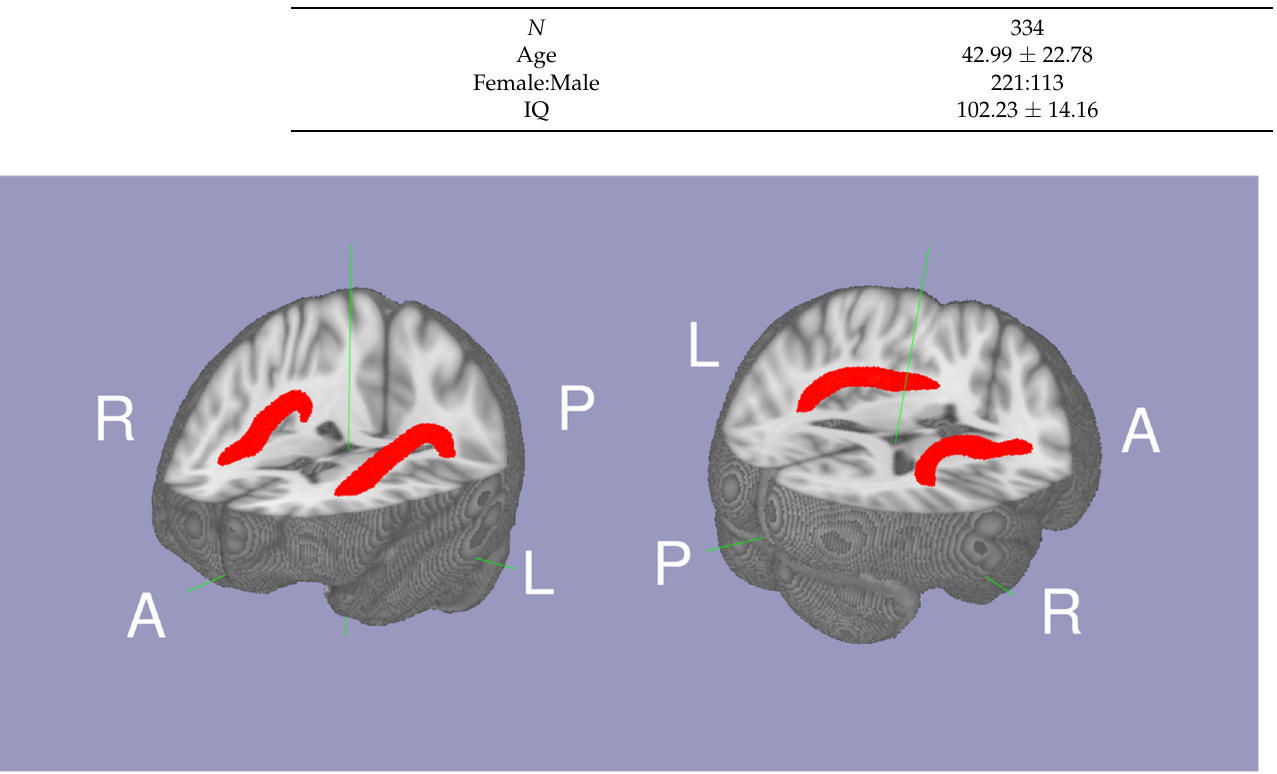
Figure 1. The mean probabilistic tractography of the arcuate fasciculi (red) between Wernicke’s area and Broca’s area white matter.